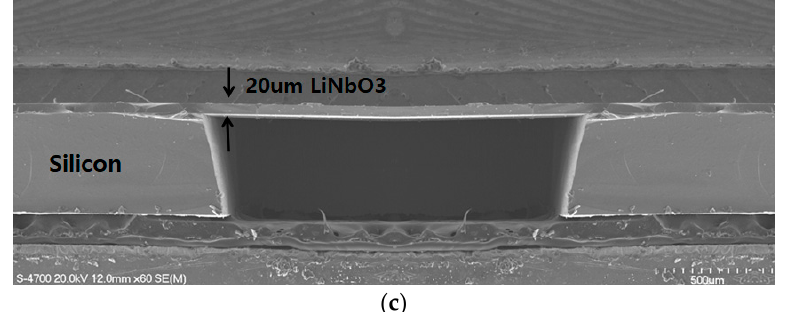
Figure 6. Optimal images of the fabricated ( a ) slanted and ( b ) chirp IDTs. ( c ) Cross ‐ sectional view of the LN membrane via SEM.